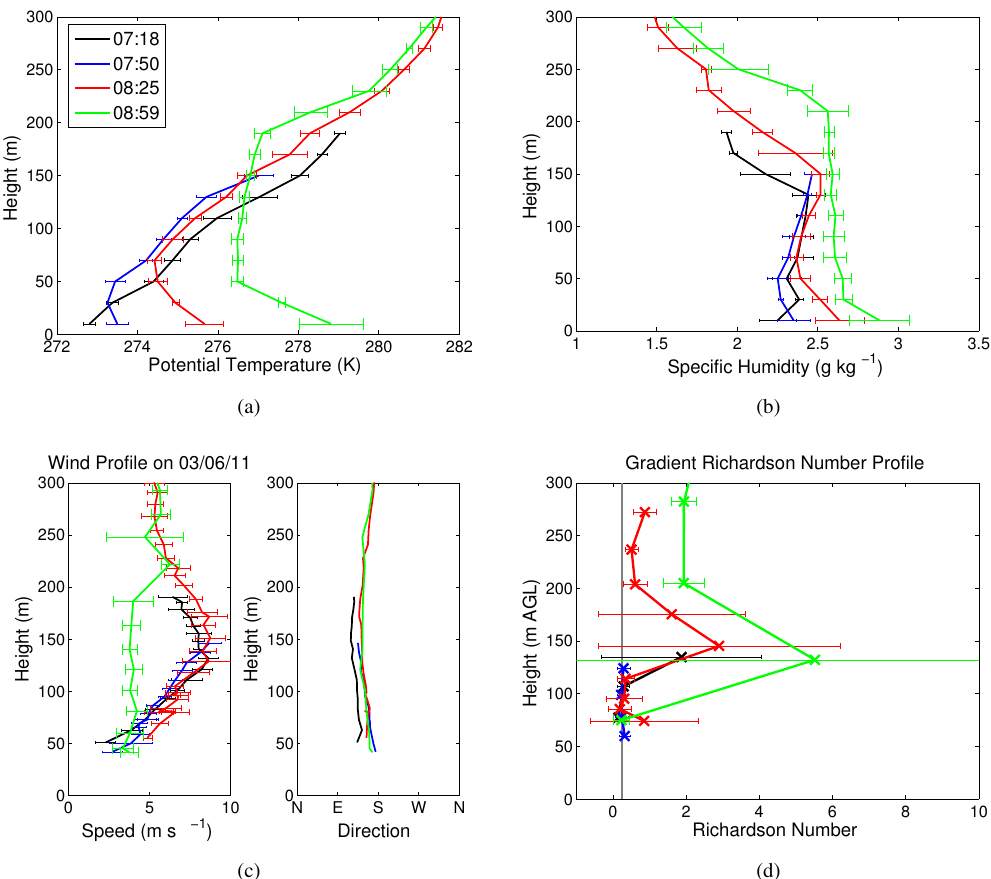
Fig. 7. SMARTSonde observations of the morning of 6 March 2011 from four sequential flights after sunrise. Provided is (a) potential temperature, (b) specific humidity, (c) wind profile using the BCF method, and (d) computed Richardson number. Local times for each flight is provided in the legend. Sunrise occurred at 6:53 LT.